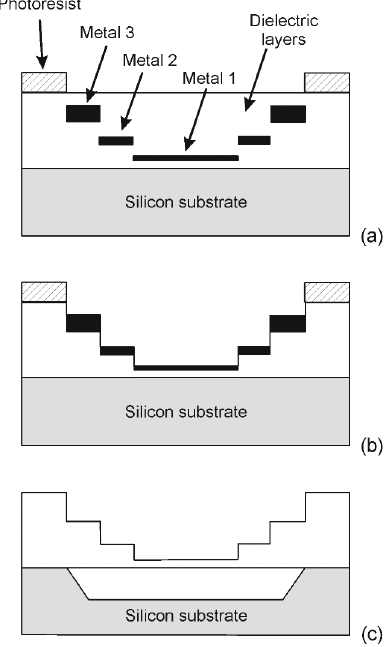
Figure 3. Schematic view of the post-processing procedure (not to scale): ( a ) definition of a thick photoresist layer; ( b ) etching of the SiO 2 with a fluorocarbon-based plasma; ( c ) removal of the masks and anisotropic etching of the silicon substrate through openings out of the represented cross-section.